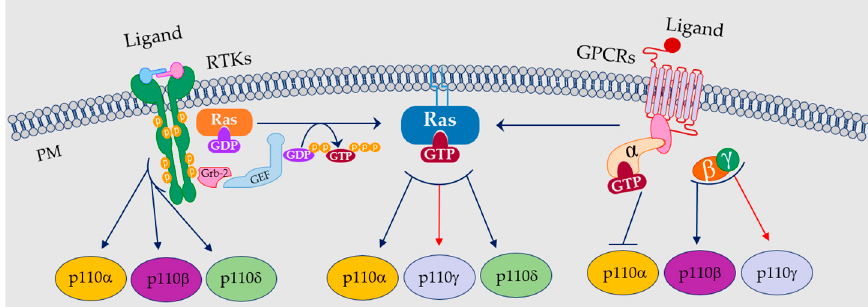
Figure 1. Phosphoinositide 3-kinases (PI3Ks) can be activated upon plasma membrane (PM) receptors, tyrosine kinases receptors (RTKs), and G protein-coupled receptors (GPCRs). p110 α , p110 β , and p110 bind directly with phosphotyrosine of RTKs ( left ); whereas, p110 α , p110 β , and p110 γ are activated by GPCRs ( right ). Both RTKs and GPCRs also activate Ras, which in turn activates p110 α , p110 γ , and p110 δ .